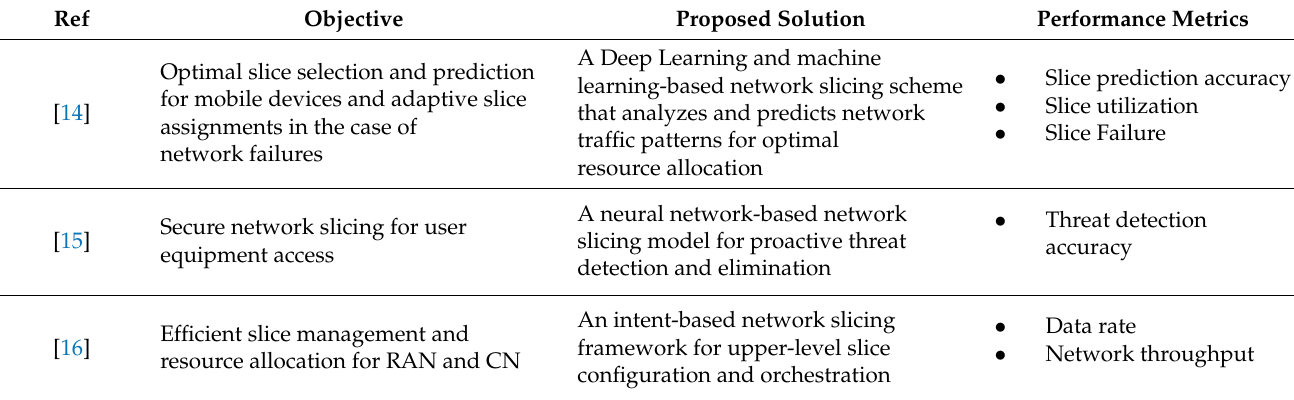
Table 1. A Summary of Related Work on Resource Allocation and Network